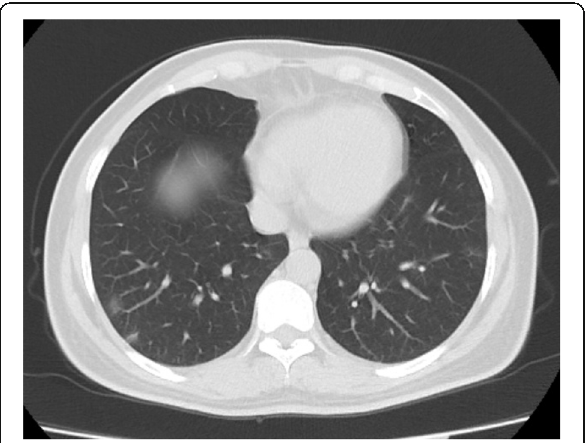
Fig. 2 There are ground glass opacities in lower lobes-CO-RADS 4